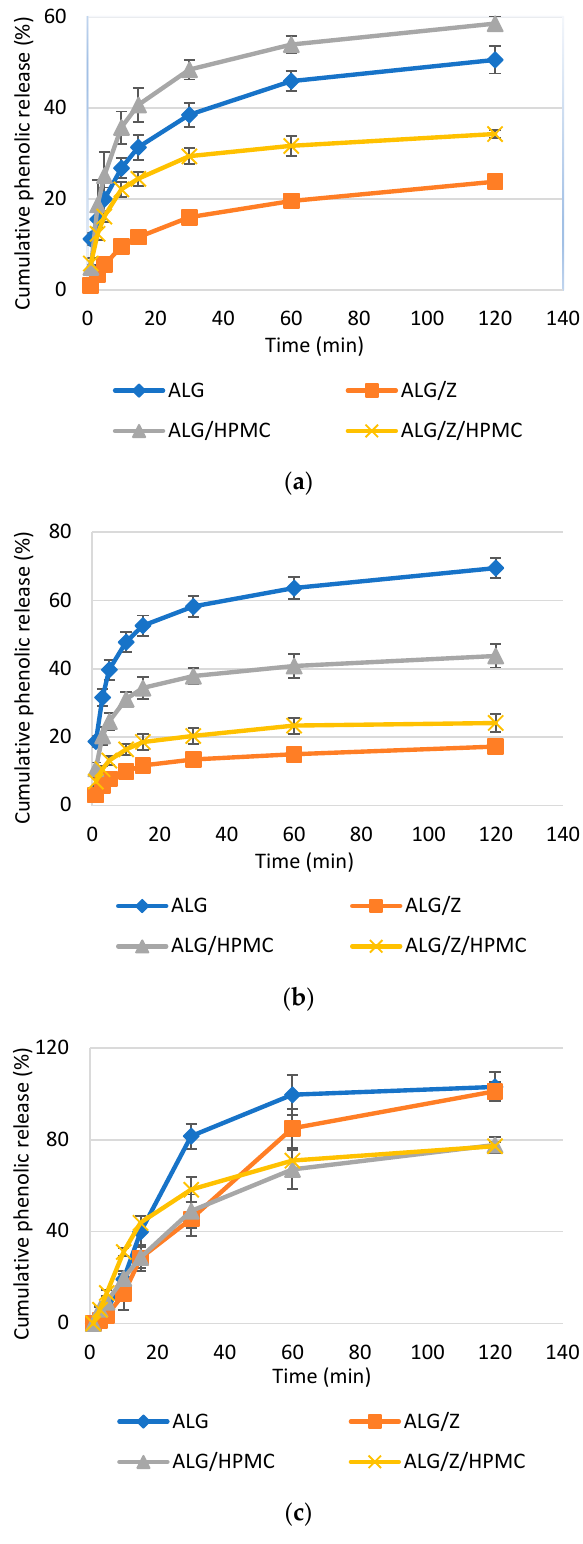
Figure 8. Cumulative release of total polyphenolic content (TPC) from microparticles in different dissolution media: ( a ) distilled water; ( b ) HCl solution (pH 1.64); and ( c ) buffer solution (pH 7.40). The error bars indicate the standard deviation of the means.